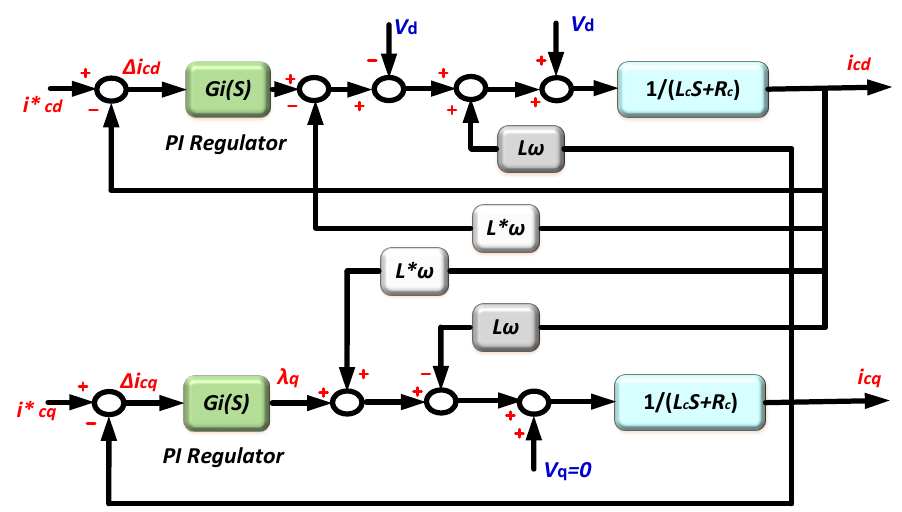
Figure 15. Current controller for NPC [141].